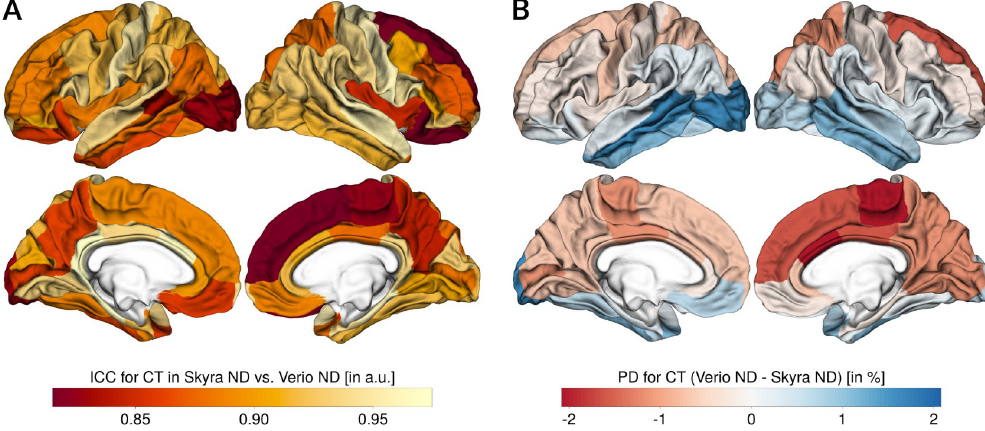
Fig 2. Reliability and percent differences for cortical thickness (CT). A: CT ICC, B: CT PD (for each panel, left column shows lateral and medial view of left hemisphere, right column shows lateral and medial view of right hemisphere), negative values:Skyra > Verio, positive values: Verio >